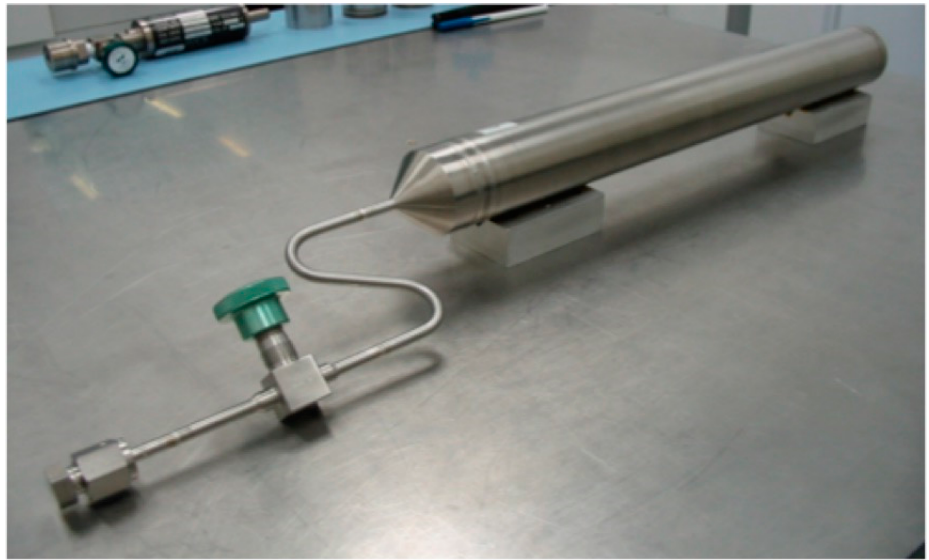
Figure 7. A flight Low-Pressure Sorbent Bed (LPSB) for the Planck sorption cryocooler prior to integration into hydrogen compressor.